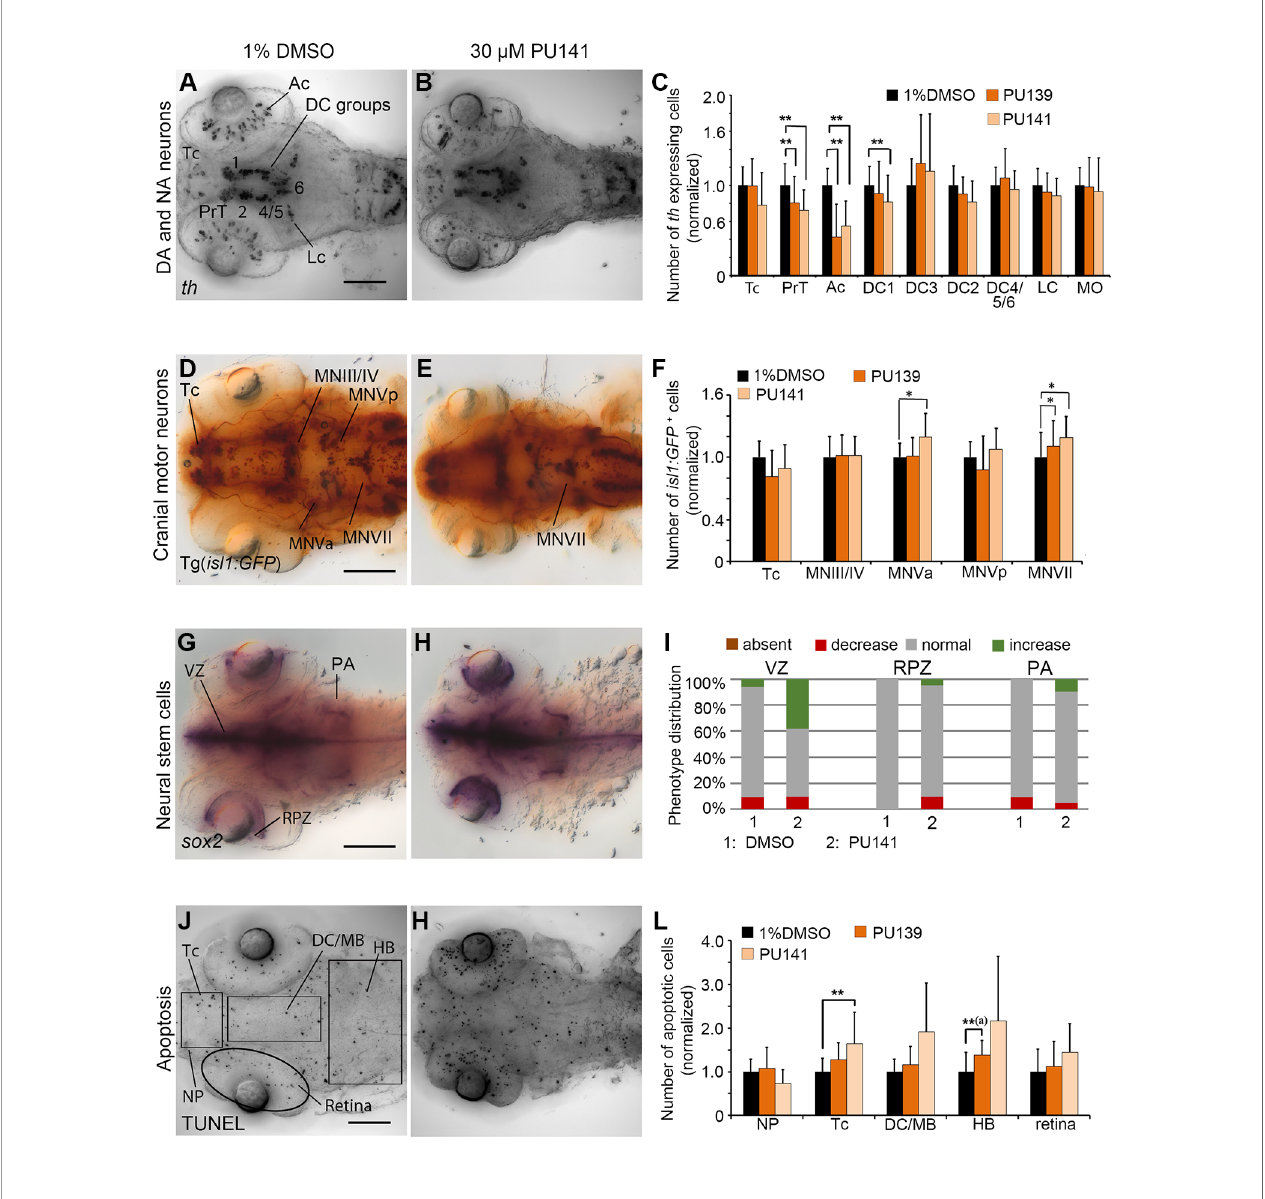
FIGURE 7 | Quanti fi cation of Secondary Screen, HAT inhibitors. (A – C) Analysis of th expression (WISH) for DA and NA neuron development. (D – F) Immunohistochemistry for Isl1-GFP positive cranial motor neurons. (G – I) WISH analysis of sox2 expression in neural stem cells. (J – L) TUNEL assay to detect apoptotic cells. Embryos were treated with the HAT inhibitors PU139 or PU141 from 24 to 72 hpf and fi xed at 96 hpf. (A, B, D, E, G, H, J, K) Dorsal views of heads of larvae, images generated from Z-Projections of image stacks, anterior at left. Scale bars represent 100 µm. Bar charts illustrate the mean cell count numbers of each neuronal subtype for (C) th expressing cells, (F) isl1:GFP transgene expressing cells, (L) apoptotic cells. Error bars depict standard deviations of the means. Asterisks indicate signi fi cant differences compared with the 1% DMSO control (p < 0.001). (I) For analysis of sox2 expression, embryos were classi fi ed into absent, decreased, normal or increased sox2 expression phenotypes (see color code) and embryo numbers were normalized to 100%. AC, amacrine cells; DA, dopaminergic; NA, noradrenergic; Tc, telencephalon; PrT, pretectum; DC, diencephalic groups; Lc, locus coeruleus; MO/AP, medulla oblongata/area postrema; MN, motor neuron cluster; VZ, ventricular zone; RPZ, retinal proliferation zone; PA, pharyngeal arches; NP, nasal placodes; DC/MB, diencephalon and midbrain region; HB,